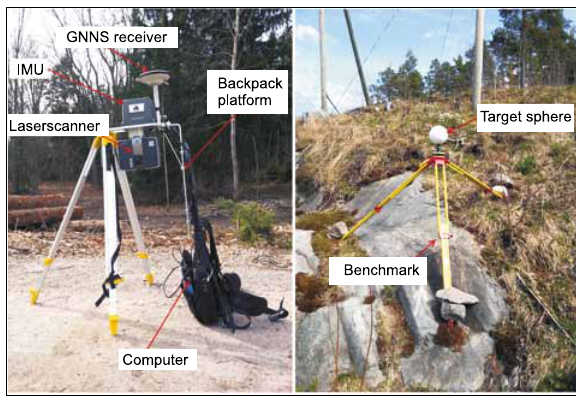
Fig. 6. The MLS system Akhka R2 (left) and a white sphere adjusted above the benchmark 95011